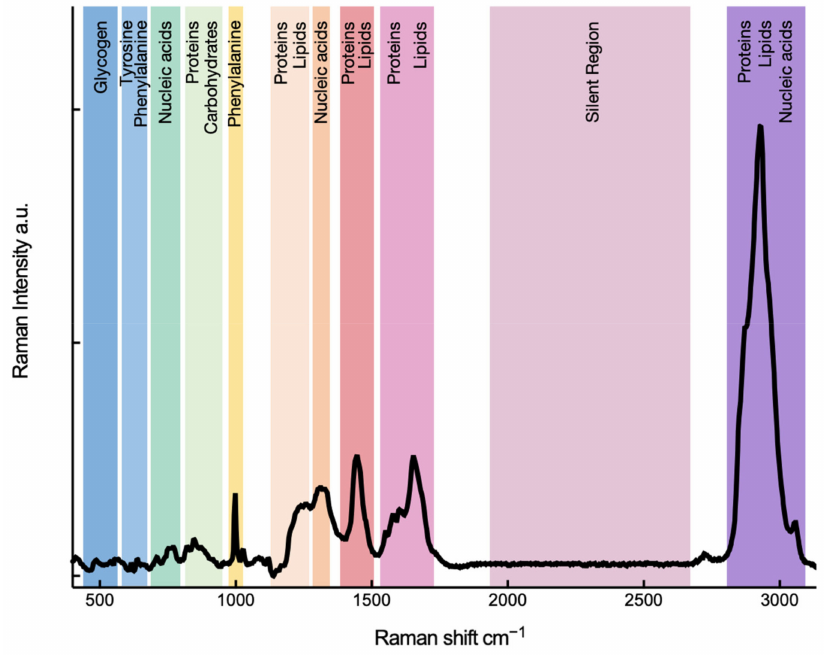
Figure 2. Raman spectrum—a cell’s fingerprint. Raman spectrum of a single cell of human primary glioblastoma U87 cell line, demonstrating various bands representative of cellular